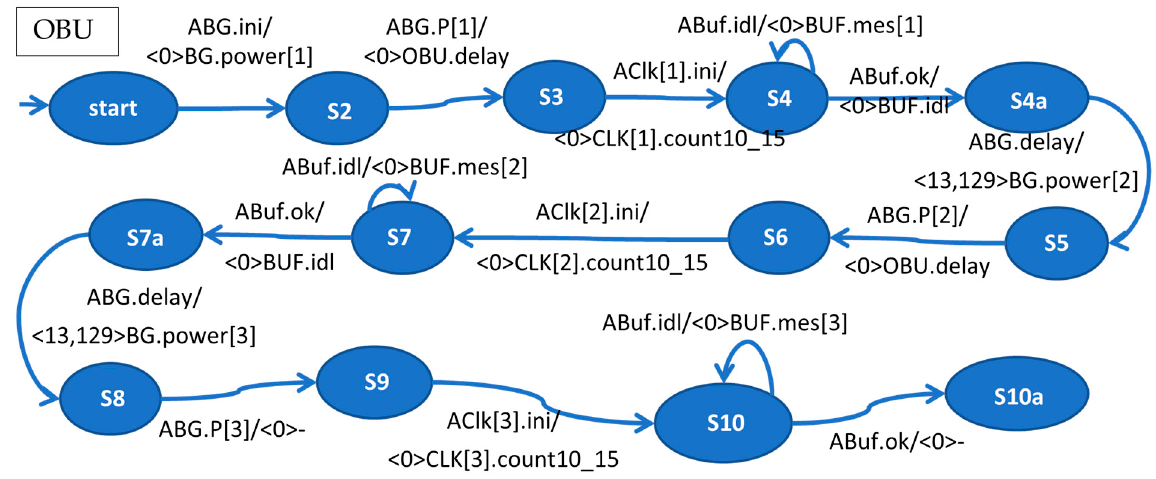
Figure 8. The automaton modeling the train onboard unit (OBU).